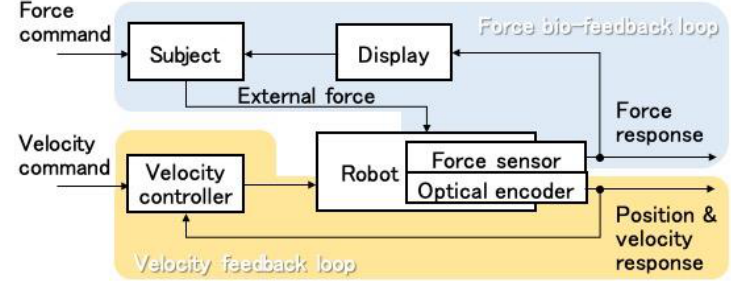
Figure 3. Training scene Figure 2 . Training scene layout.